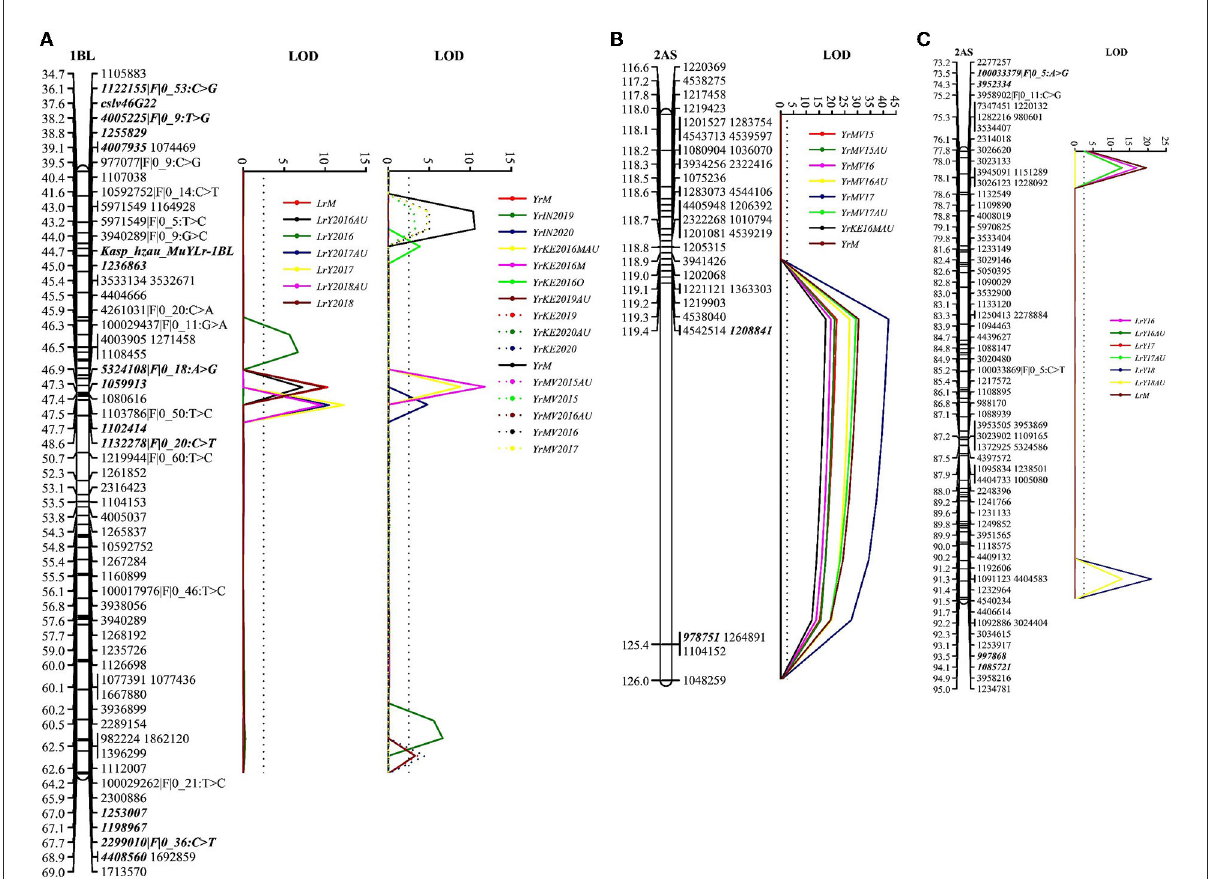
FIGURE3 The logarithm of odds (LOD) plot of quantitative trait loci (QTL) for adult plant resistance to both stripe rust and leaf rust on chromosomes 1BL (A) , 2AS for YR (B) , and 2AS for LR (C) in the Apav#1 × Mucuy RIL population. Positions (cM) of the molecular markers on chromosomes are shown on the vertical axes; cumulative genetic distances of linkage groups are also shown. QTL flanking markers are in